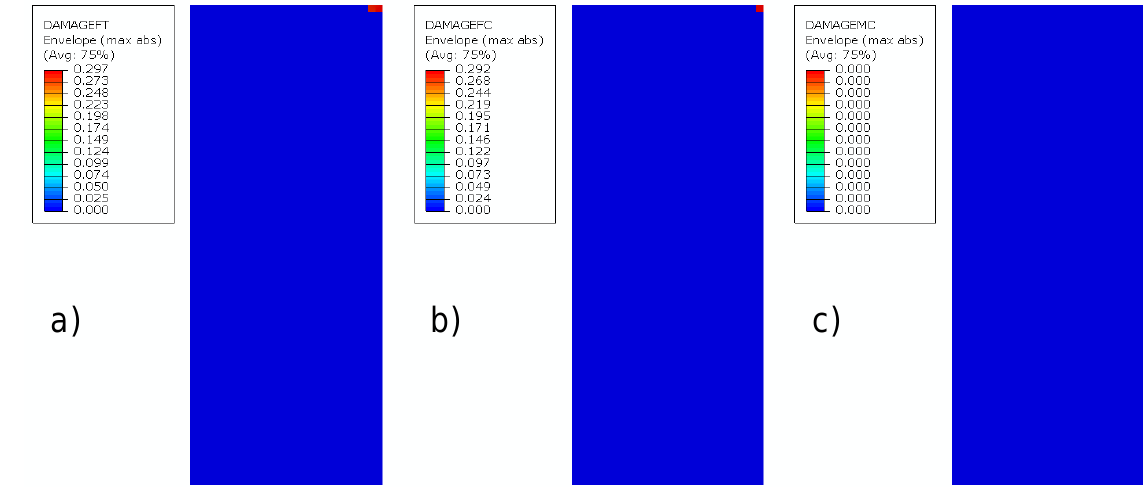
Figure 5. Other three damage distributions of the eccentric impact case with the root and one side edge clamped: ( a ) fibre tension, ( b ) fibre compression and ( c ) matrix compression.